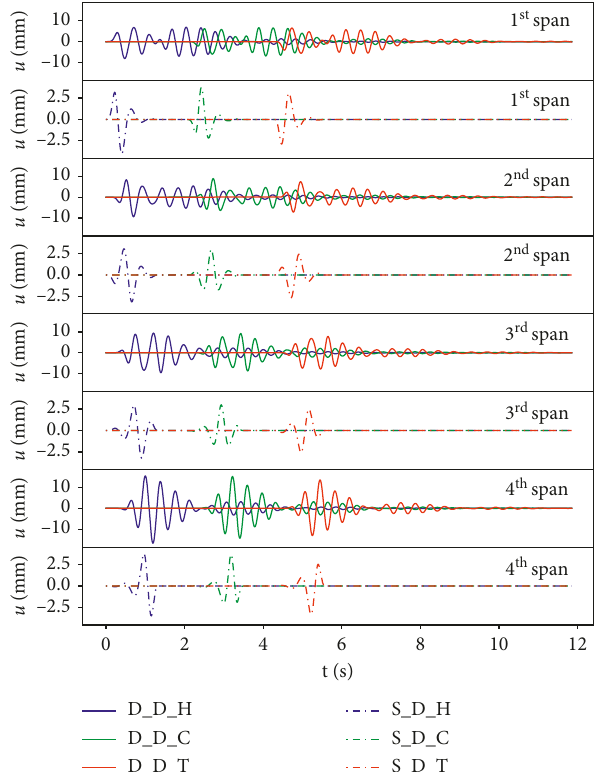
Figure 13: Central displacements of each span of the 4-span continuous purlin due to the high-speed train passing with speed 344.797 km/h (S_D_H, S_D_C, and S_D_Tstand for static displacements of the purlin due to the passing of head, coupler, and tail, respectively; D_D_H, D_D_C, and D_D_T stand for dynamic displacements of the purlin due to the passing of head, coupler, and tail, respectively).